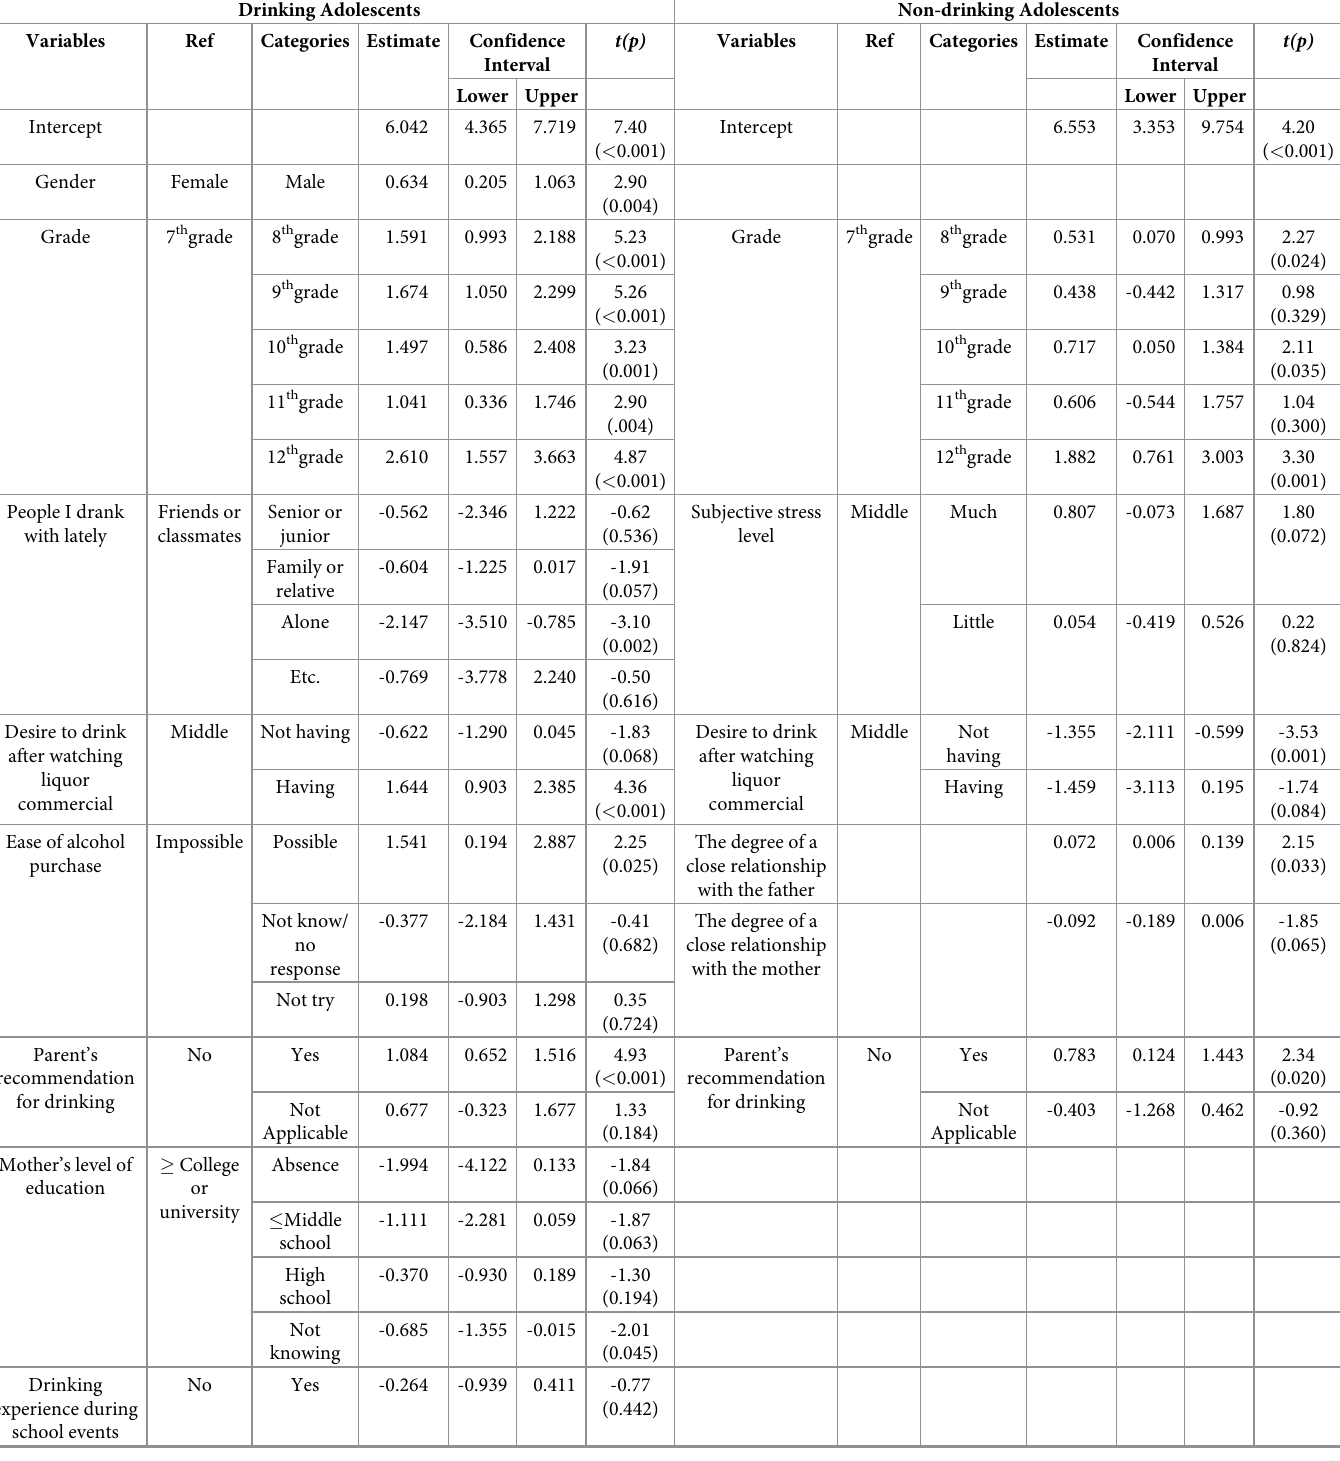
Table 4. Factors influencing sustainable use of alcohol in drinking and non-drinking adolescents by hierarchical multiple